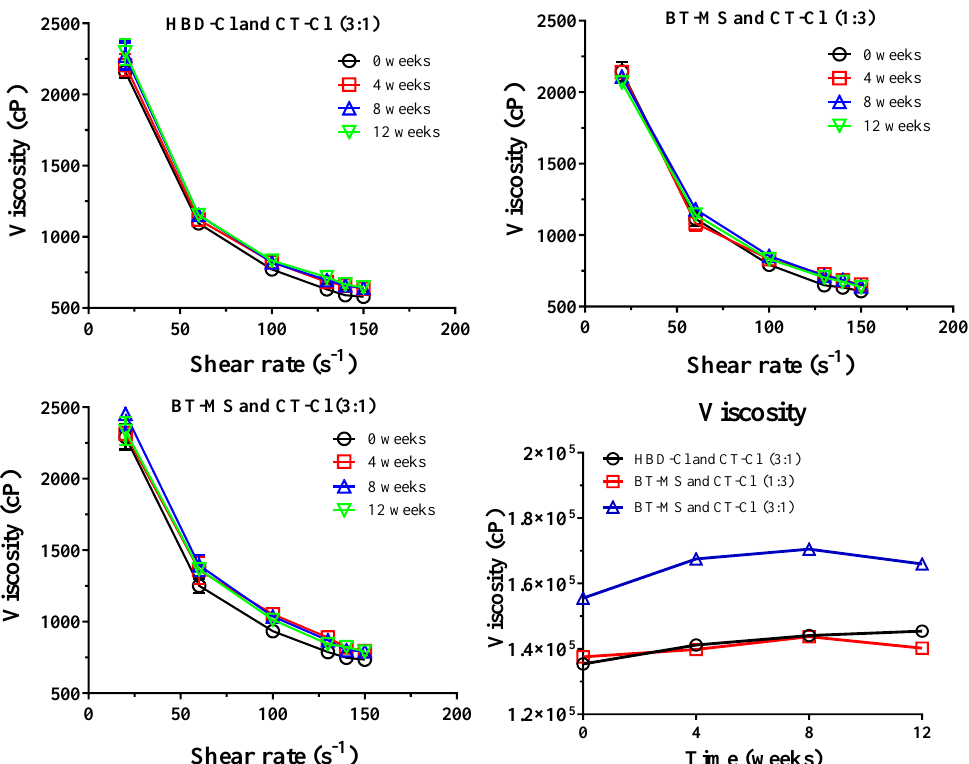
Figure 6. Rheological profiles and viscosity values obtained for the selected prototypes as a function of time.